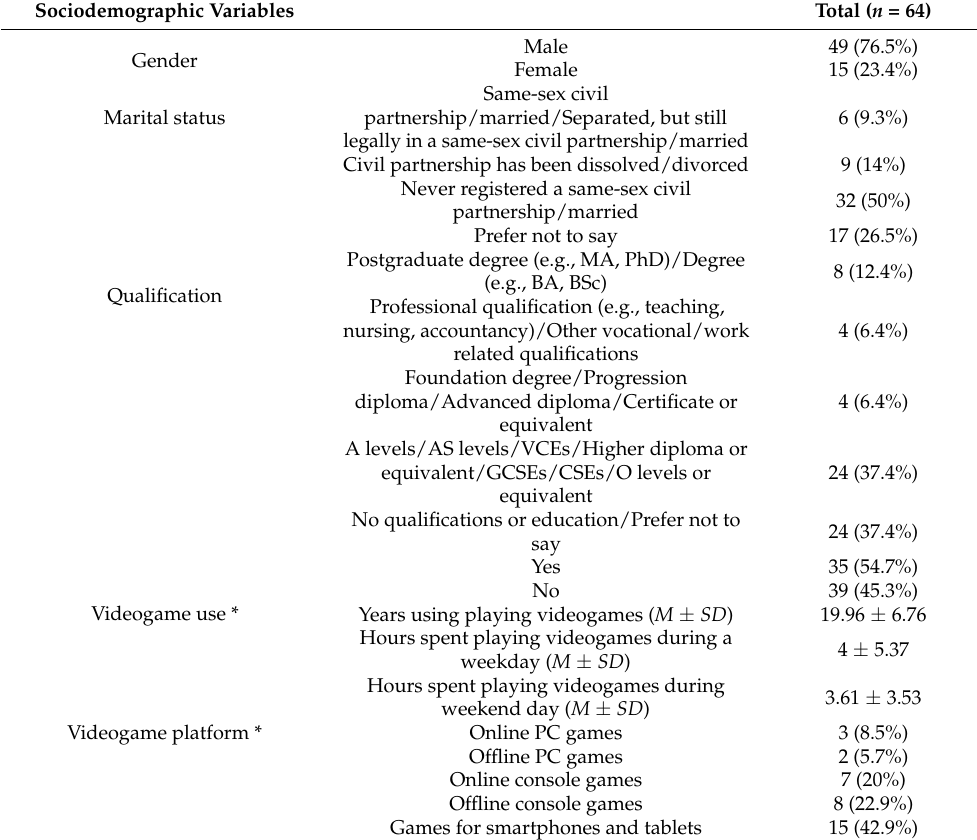
Table 1. Demographics and videogame use information (clinical